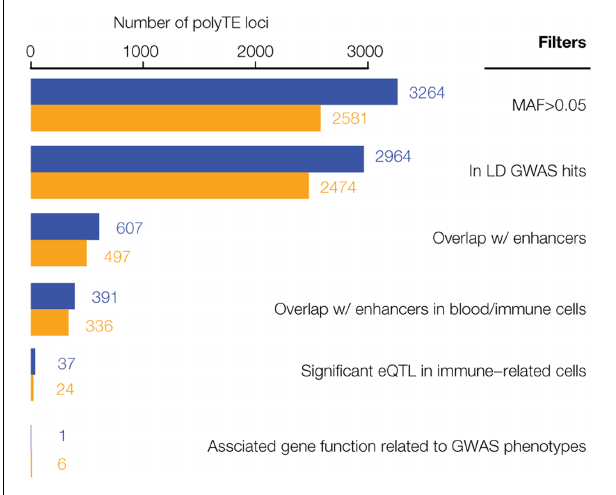
FIGURE 2 | Results of the genome-wide screen for polyTE disease-associations. As illustrated in Figure 1 , a series of filters was applied to screen for a final set of high-confidence polyTE disease-associations. The number of polyTE insertions that remain after the application of each successive filter is shown for the African (AFR – blue) and European (EUR – orange) population